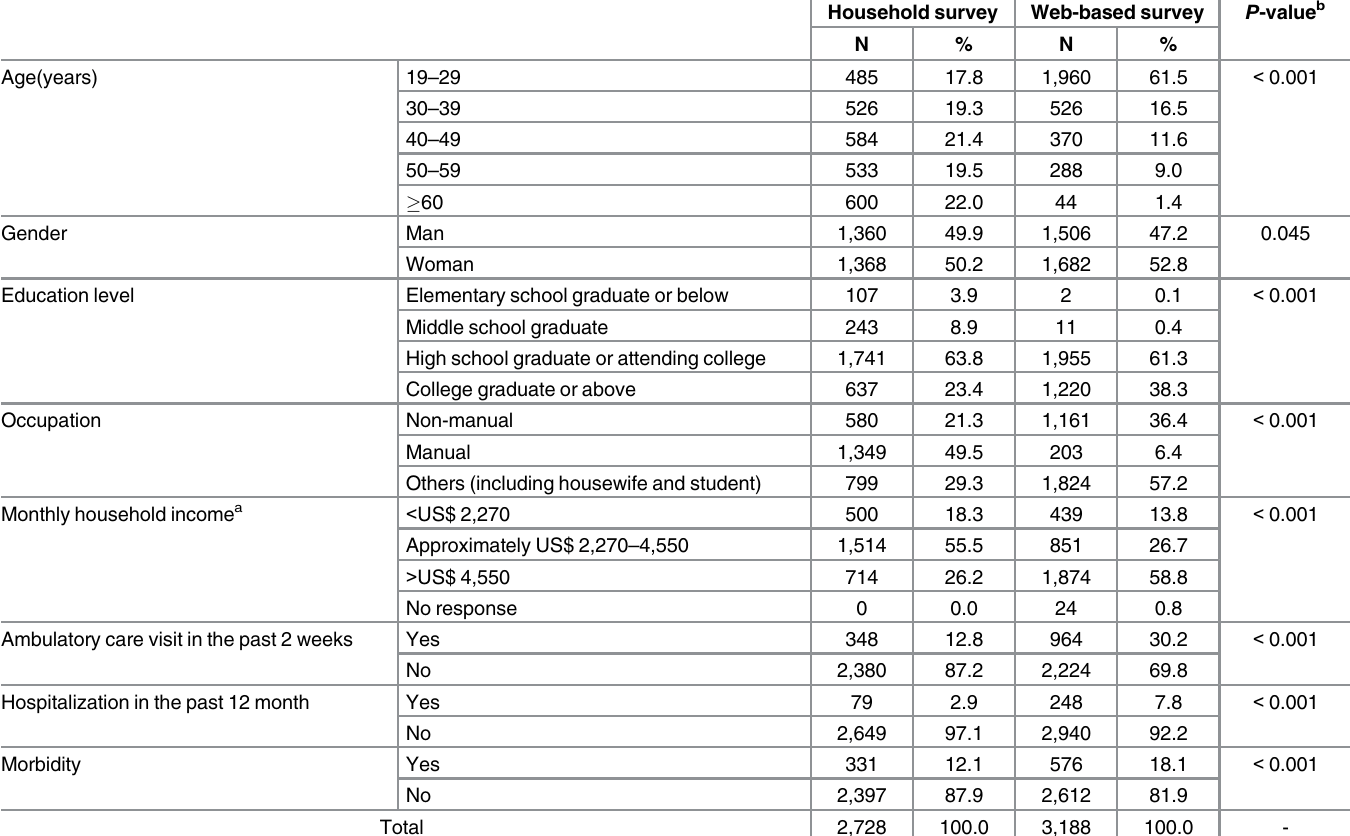
Table 1. Socio-demographic and clinical information for the study